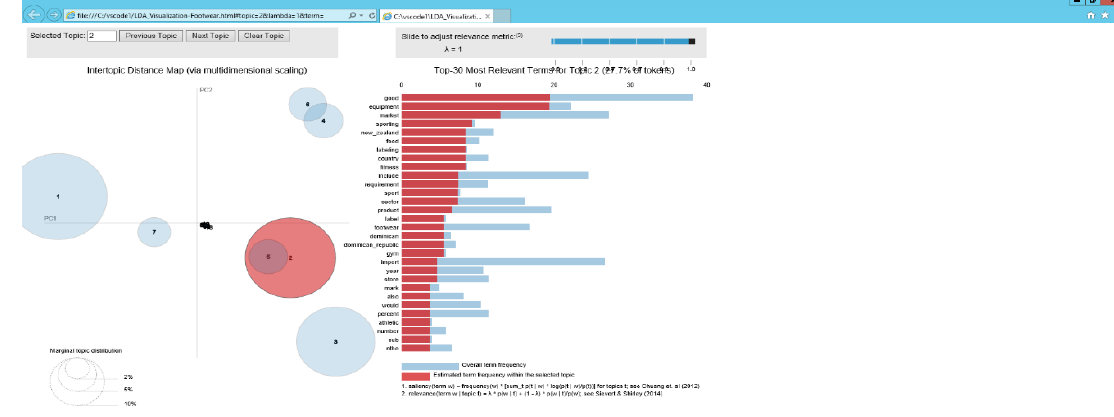
Figure 8. Footwear: Topic 2. This image shows New Zealand and key terms to the right.